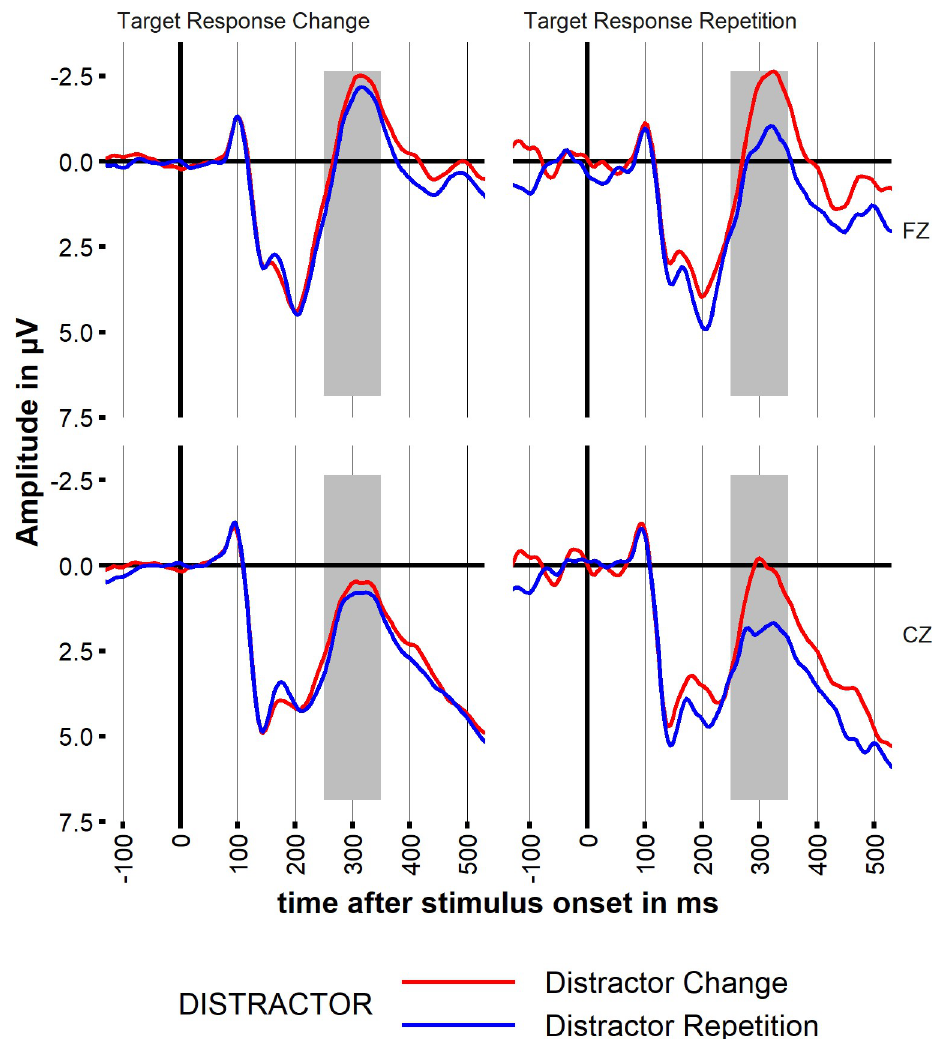
Fig 3. ERPs. Stimulus-locked event-related brain potentials (ERPs) on midline electrodes FZ and CZ separated by TARGET (Target Response Repetition (prime and probe target were different in identity, but were mapped on the same response button), Target Response Change (prime and probe target were associated with different responses). Lines represent DISTRACTOR (Distractor Repetition from prime to probe; Distractor Change (distractors in prime and probe were associated with different responses)). Baseline: 100 ms pre-stimulus. Shaded areas indicate time window for statistical analysis.